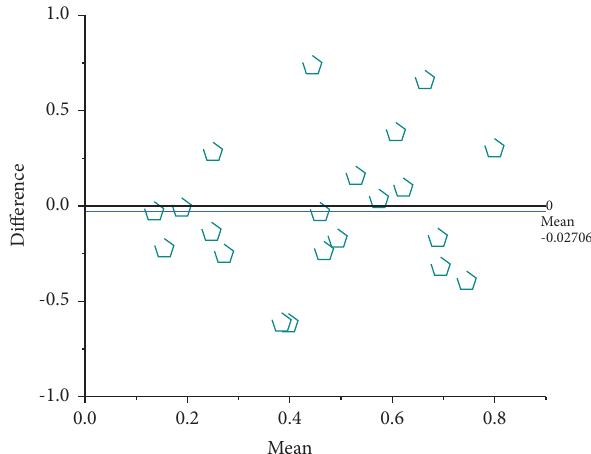
Figure 6: F1 values for a different number of iterations.